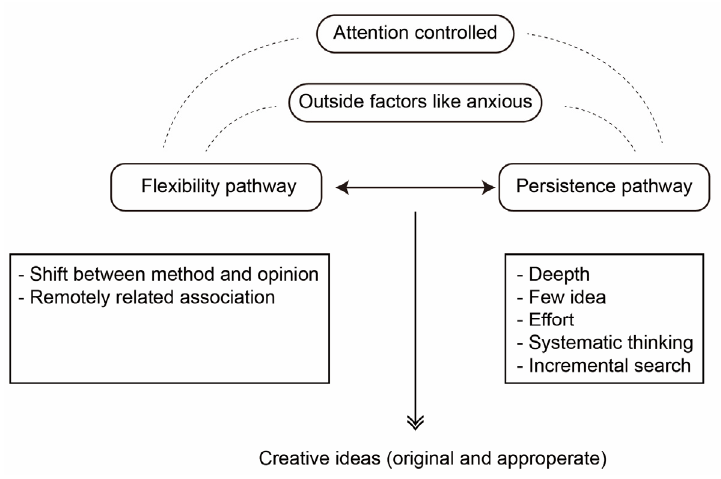
Figure 8. Dual pathway model schematic.